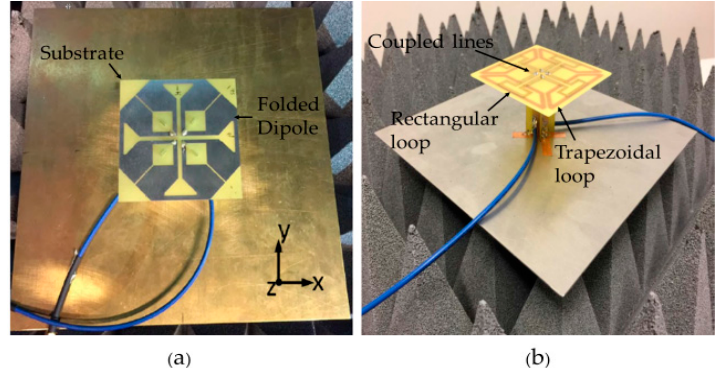
Figure 12. ( a ) Fabricated prototype of folded dipole [28]. ( b ) Fabricated Prototype of magnetoelectric loop dipole [29].